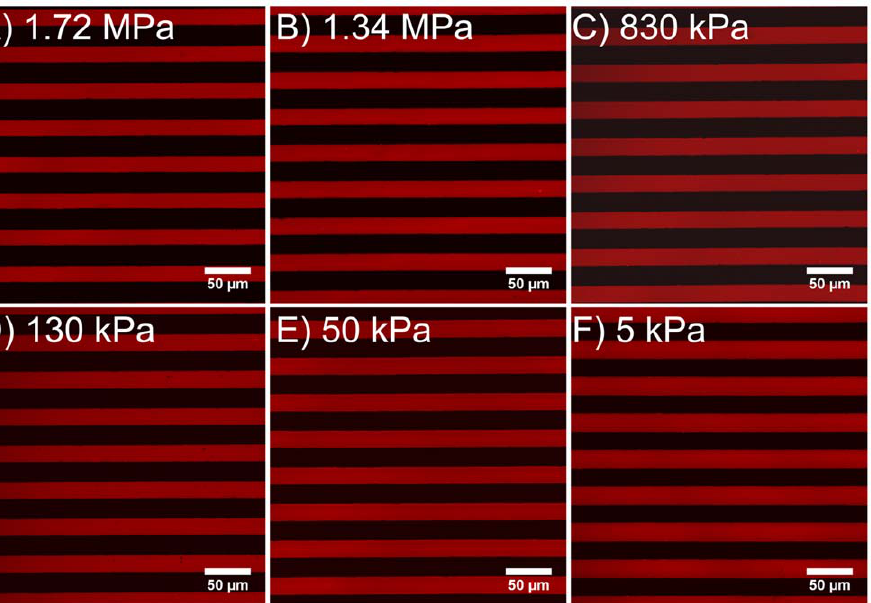
Figure 5. Representative examples of fluorescently labeled fibronectin micropatterned on the different PDMS formulations. The protein pattern is transferred with high fidelity on all the PDMS formulations indicating the substrates exhibit similar protein adsorption from the PDMS stamps (made from Sylgard 184) used for microcontact printing. The different images are for (A) 1.72 MPa, (B) 1.34 MPa, (C) 830 kPa, (D) 130 kPa, (E) 50 kPa and (F) 5 kPa elastic modulus PDMS formulations. Scale bars are 50 m m.